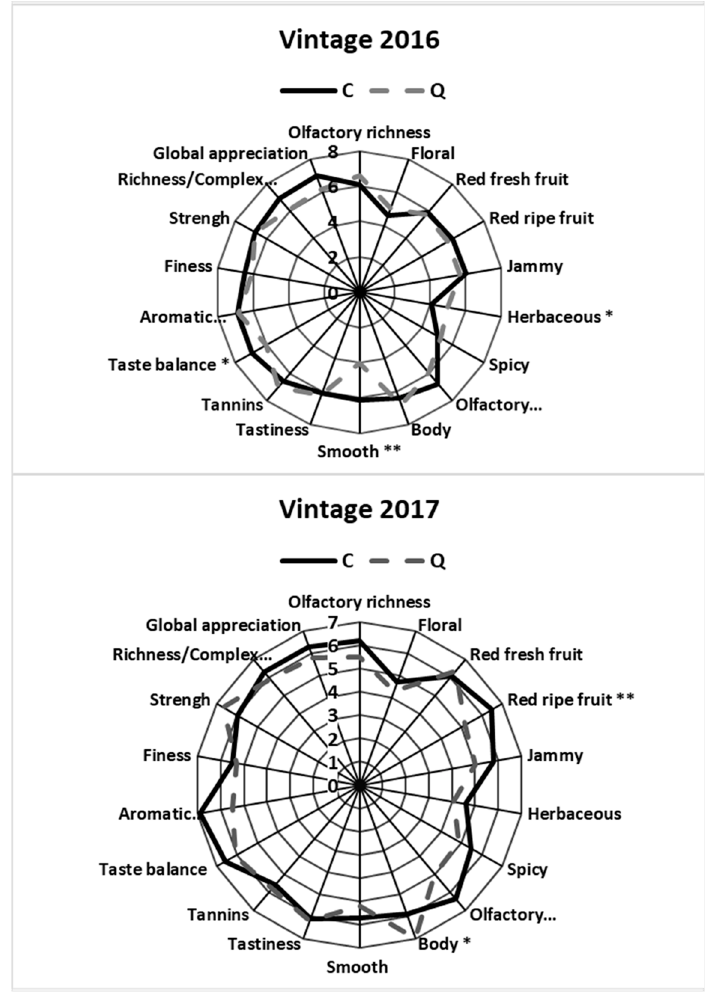
Figure 1. Sensory profiles of wines in Colombara (C) and Quaiara (Q) in the years 2016 and 2017. Where present, *; **; *** indicate a significant difference at α ≤ 0.05, 0.01, and 0.001.